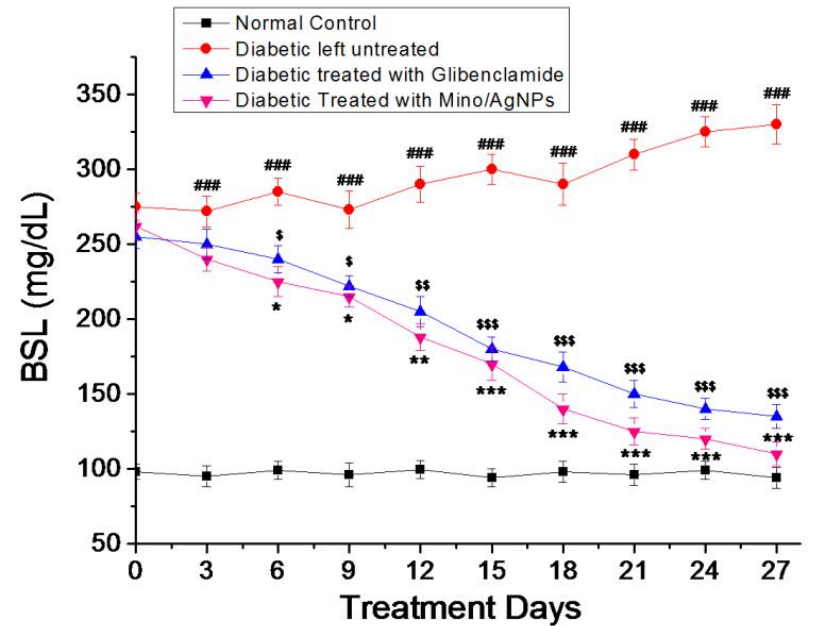
Figure 7. Level of blood sugar (mg/dl) for various study groups. Group-I; normal control, Group-II; diabetic left untreated, Group-III; diabetic treated with glibenclamide, Group-IV; diabetic treated with mino/AgNPs. ‘#’ indicates a significant difference between the control and diabetic groups; ‘$’ indicates a significant difference between the diabetic and glibenclamide treatment groups; ‘*’ indicates a significant difference between the diabetic and mino/AgNPs treatment groups. Each bar represents the value of mean ± SD of eight replicates. Statistical icons: $, * = p ≤ 0.05; $$, ** = p ≤ 0.01; ###, $$$, *** = p ≤ 0.001.